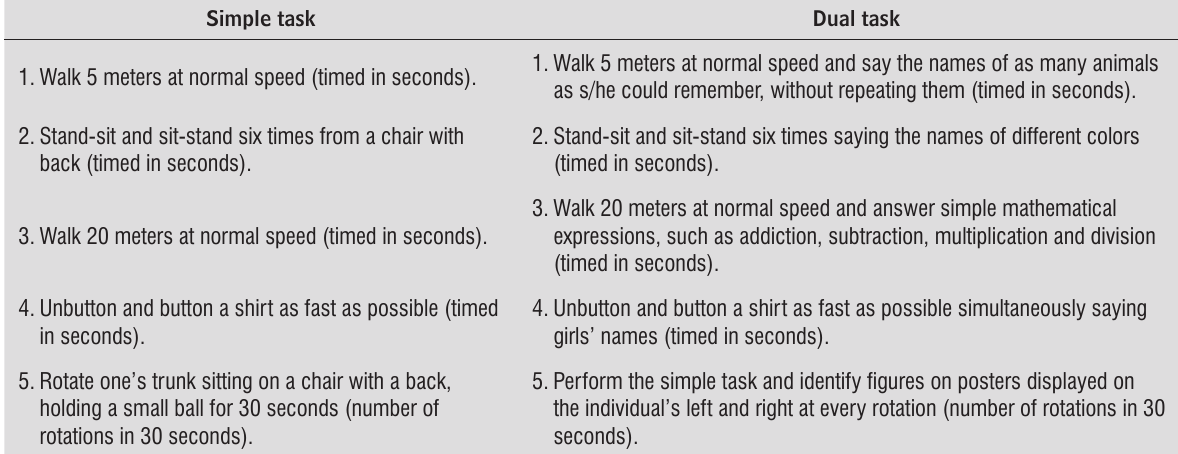
Table 1 - Assessing the performance of simple and